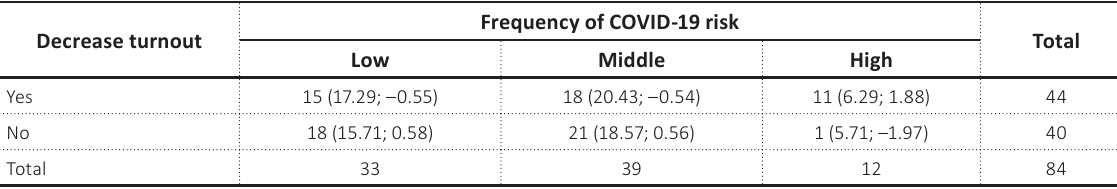
Frequency of COVID-19